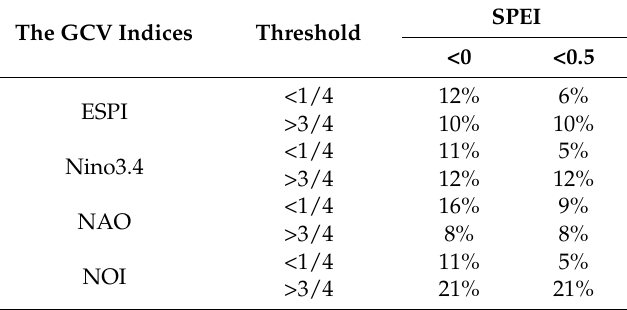
Table 4. The probabilities of Copula